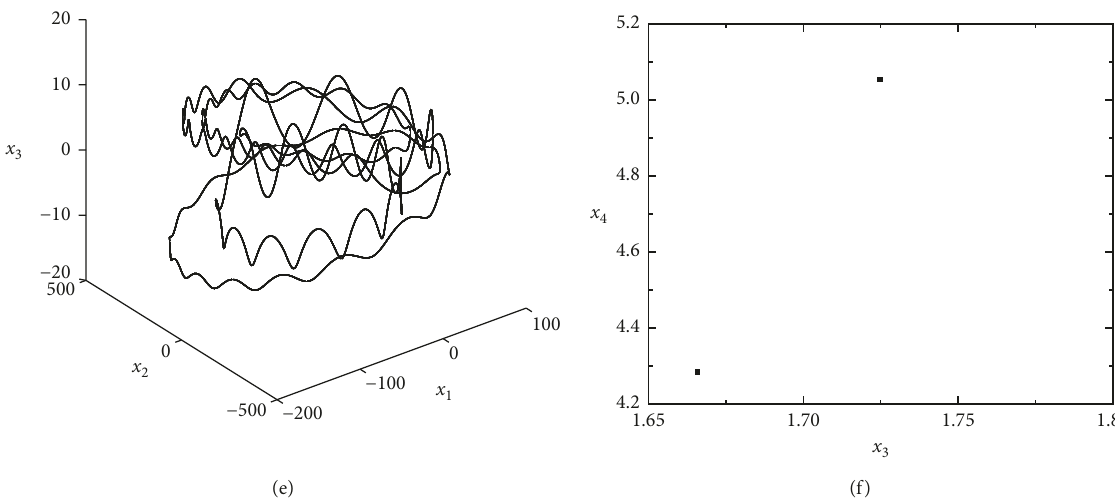
Figure 14: Periodic motion of the composite shell. (a) Waveform in the plane ( t, x dimensional phase portrait in the plane ( x portrait in the plane ( x